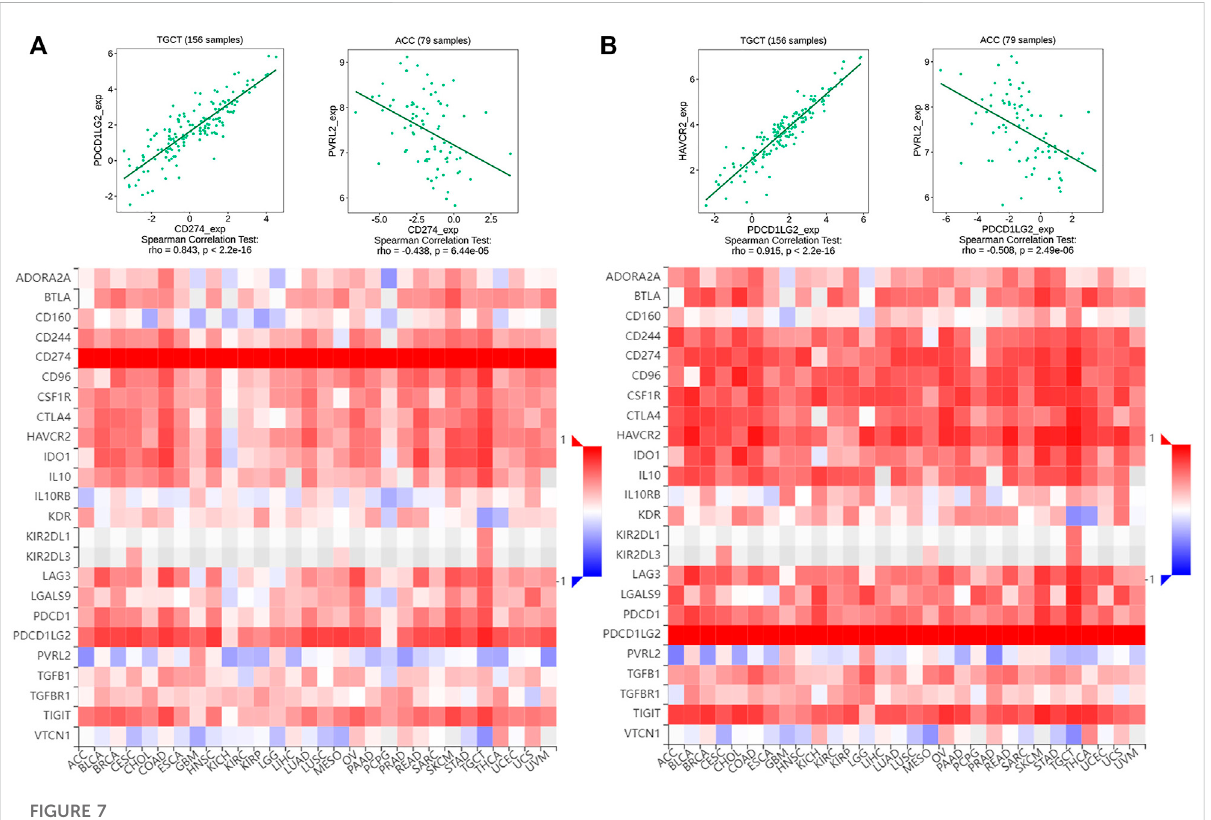
FIGURE 7 Correlation of multiple immunosuppressive genes including CD274/PDCD1LG2. Heatmap of the correlation between (A) CD274 and (B) PDCD1LG2 and immunosuppressive genes. Red represents positive correlations, and blue represents negative correlations. The strongest correlation is shown at the